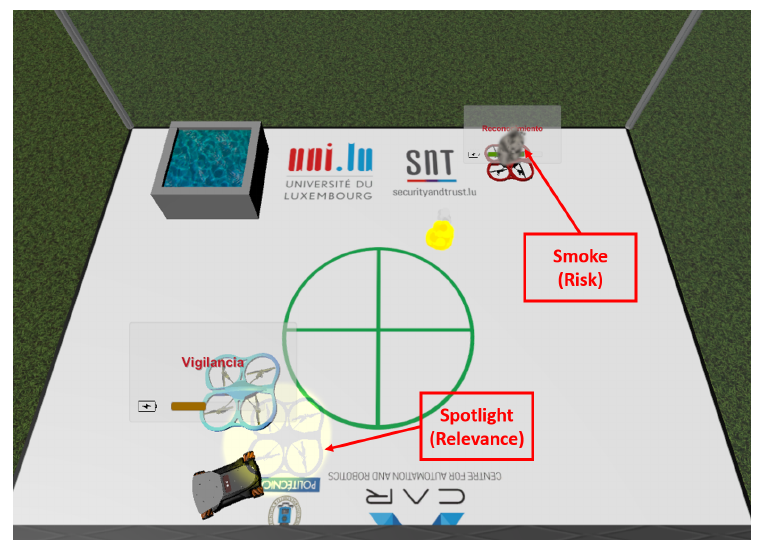
Figure 11. Predictive virtual reality interface.